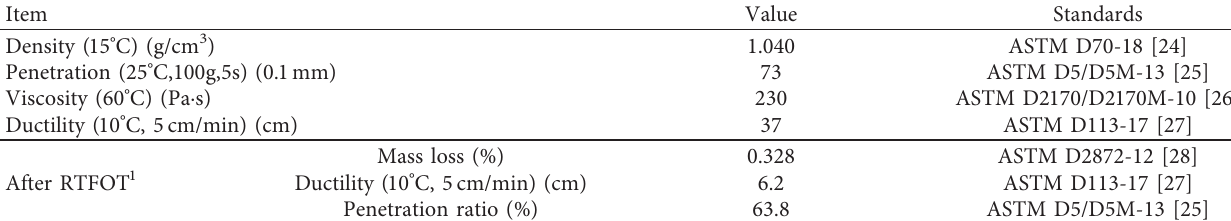
Table 1: Properties of base asphalt (A-70).